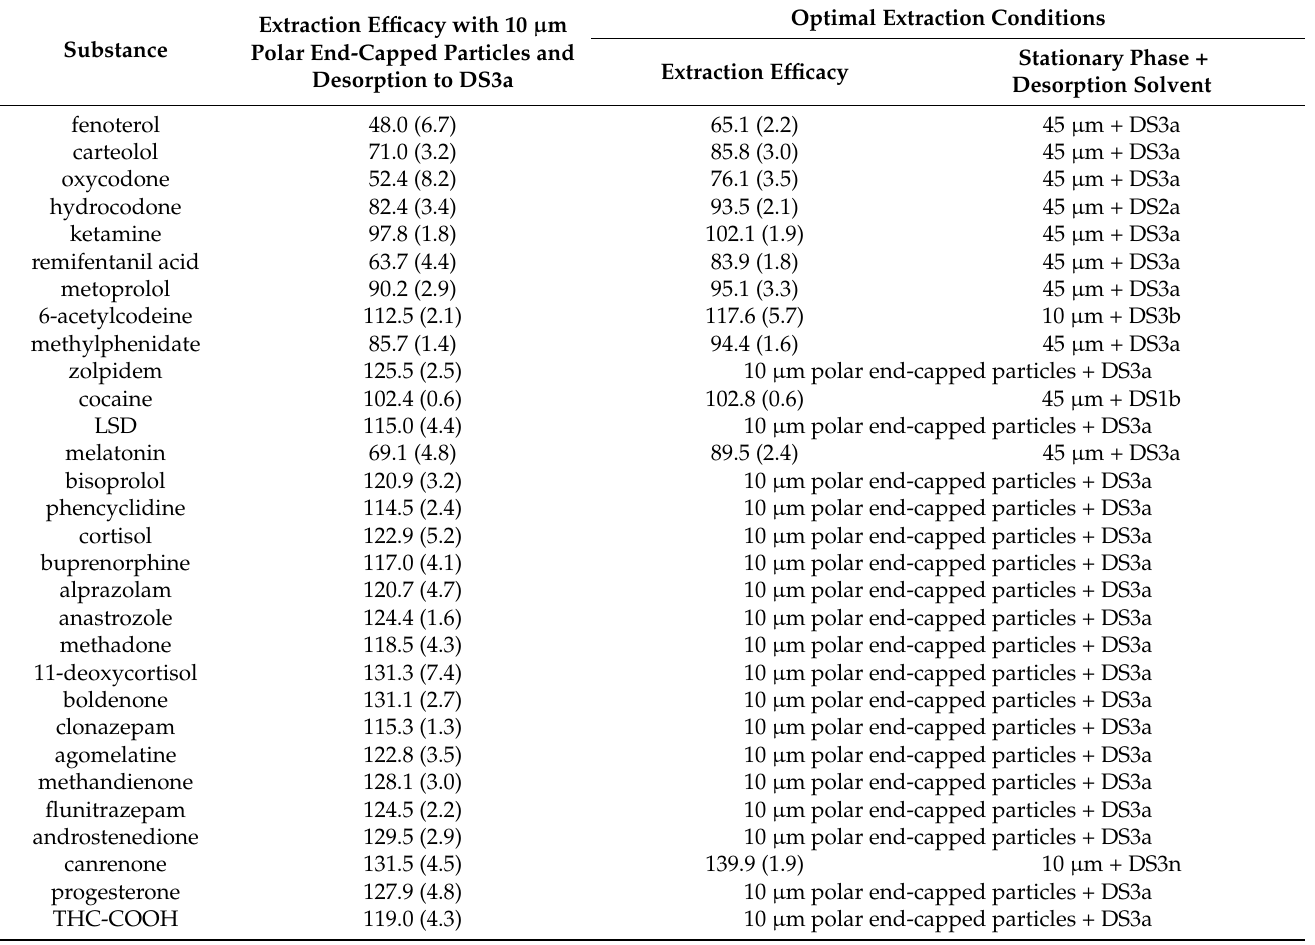
Table 1. Optimal extraction efficacies [%] and conditions. Relative standard deviations [%] given in brackets, n = 3, substances arranged by retention order.